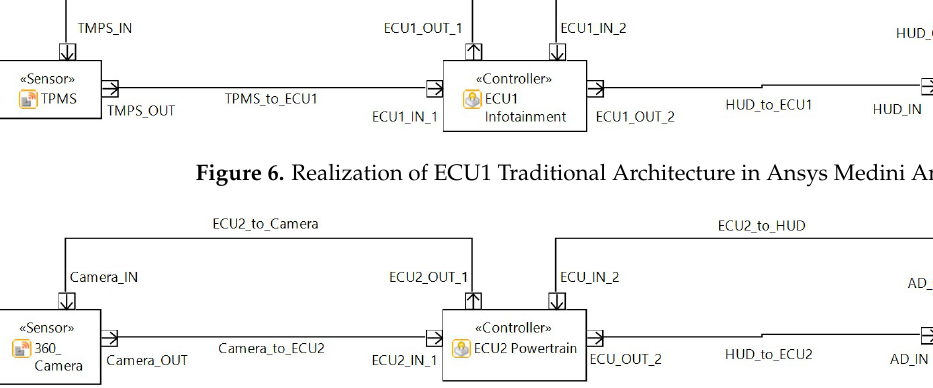
Figure 7. Realization of ECU2 Traditional Architecture in Ansys Medini